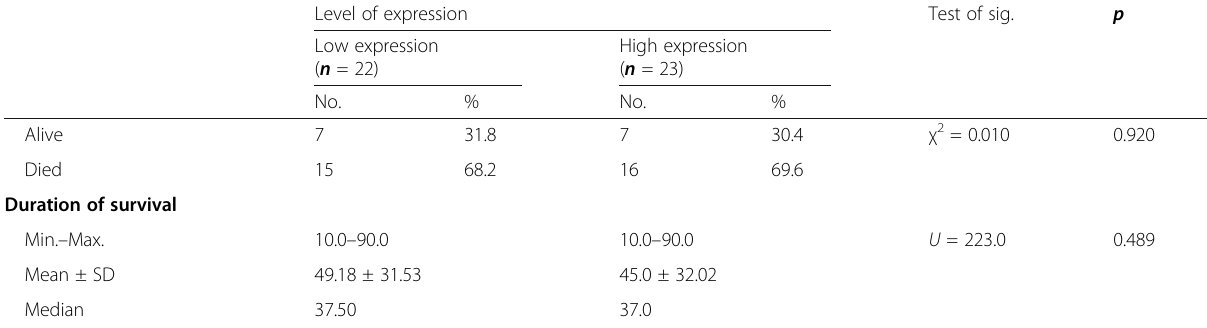
Table 4 Comparison between low and high DNMT3a gene expressors with respect to their demographics as well as clinical data (Continued) Level of expression Test of sig. p Low expression ( n =